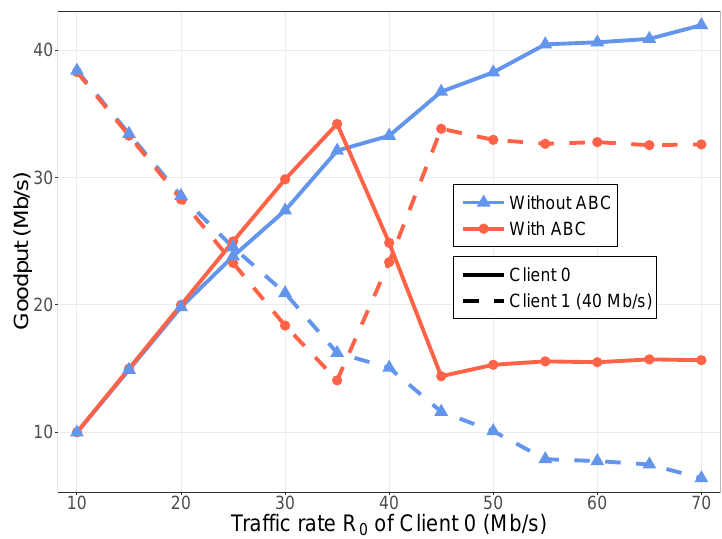
Figure 4. Resource sharing with constant bit rate (CBR) traffic; Client 0 sends CBR traffic as indicated on the x -axis and Client 1 sends CBR traffic at 40 Mb/s.